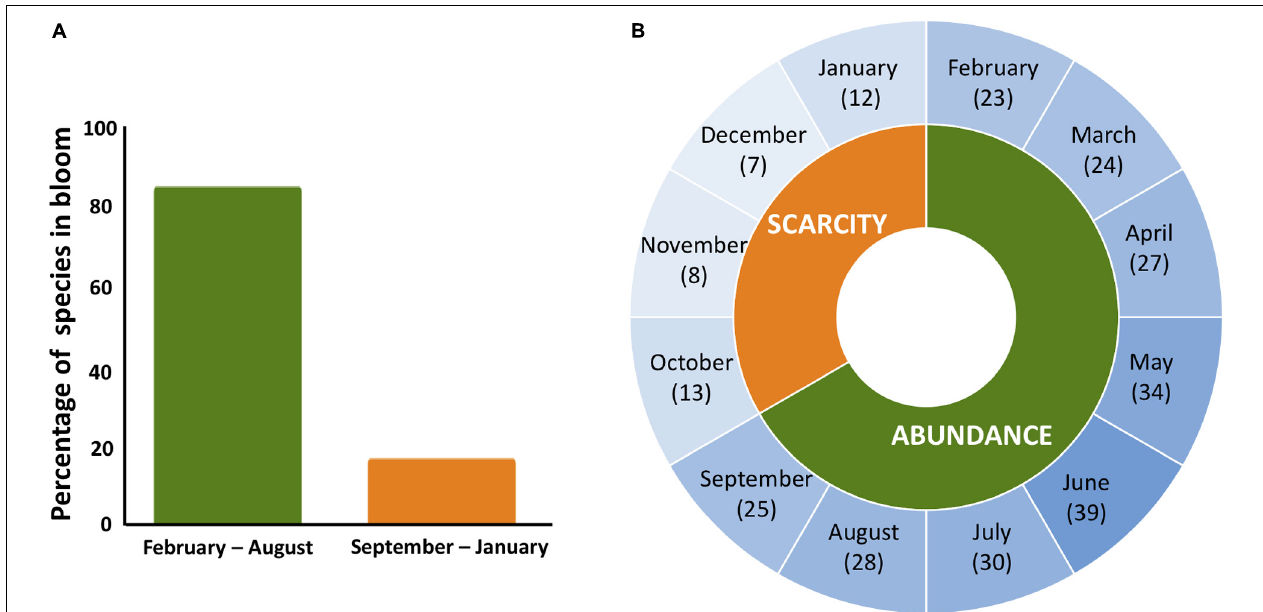
FIGURE 1 | Flower phenology in PR. (A) Blooming rate of the 61 trees in PR that are regularly visited by the honey bees throughout the year. (B) In PR, the number of species in bloom is highest in June and lowest in December. For 4 months (October–January) floral resources are scarce with an average of ten species in bloom compared to the other 8 months (February–September) when, on average, 29 species are flowering. Data from Little et al.